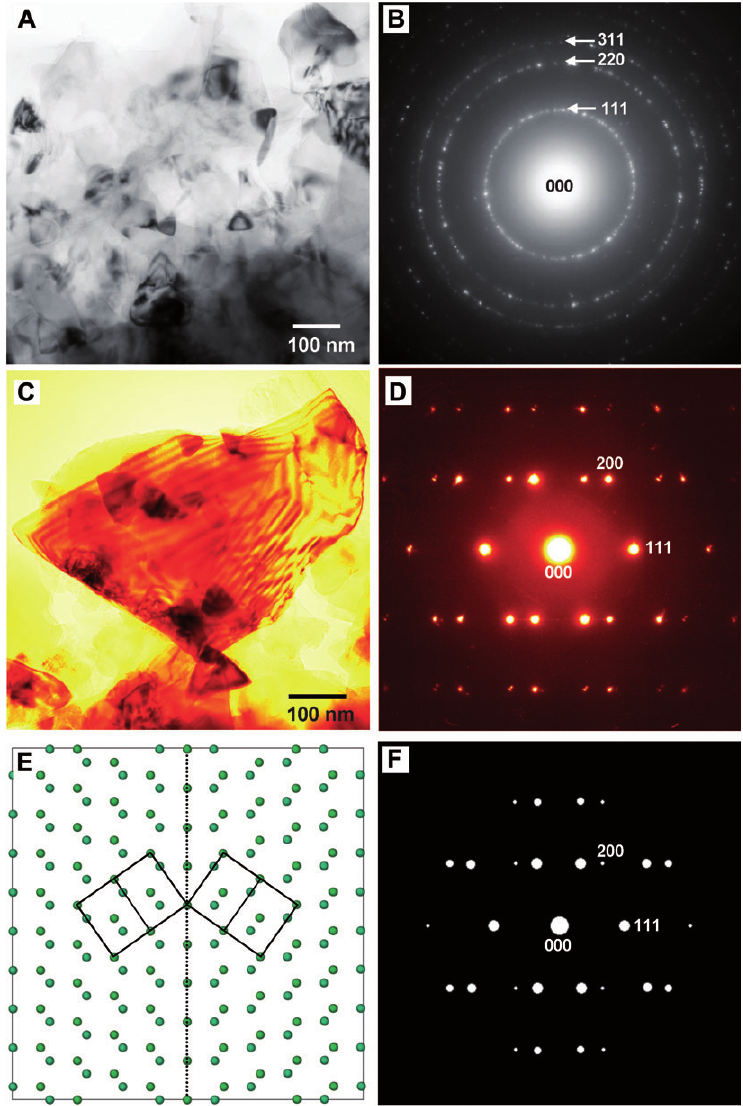
Figure 27 (A) TEM image and (B) electron diffraction pattern of c-BN nanoparticles synthesized from r-BN. (C) TEM image and (D) elec- tron diffraction pattern of c-BN nanoparticle taken along [011]. (E) Atomic structure model of {111} twin structure of c-BN along [011]. (F) Calculated electron diffraction patterns of twin structure of